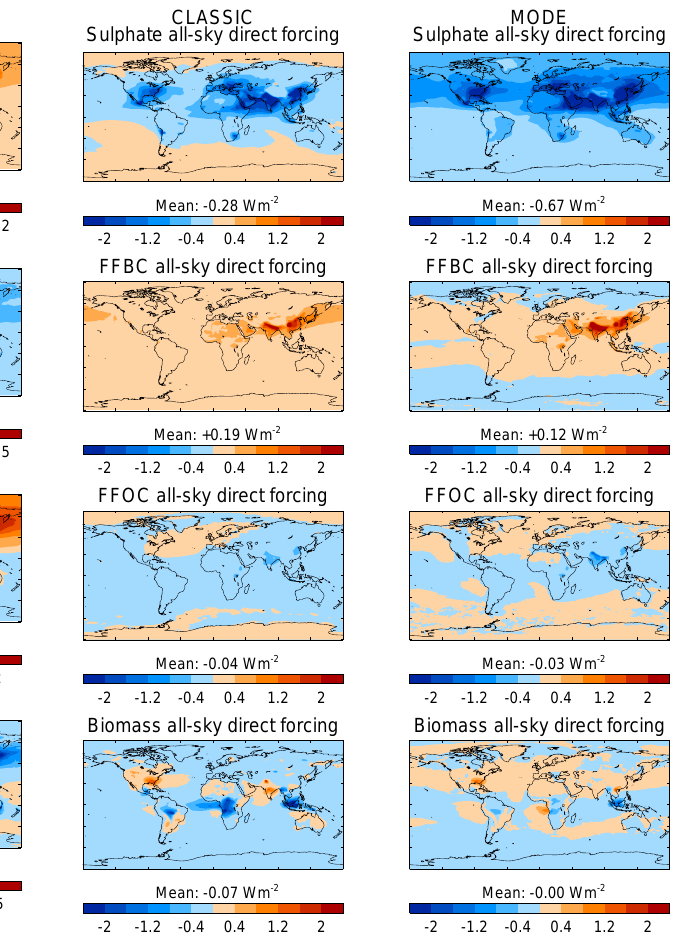
Fig. 8. All-sky shortwave direct radiative forcing at the top of the atmosphere, in Wm − 2 , for 1850–2000 changes in (top to bottom) sulphate, fossil-fuel black carbon (FFBC), fossil-fuel organic car- bon (FFOC), and biomass-burning aerosols, as simulated by the CLASSIC (left) and GLOMAP-mode (right) aerosol